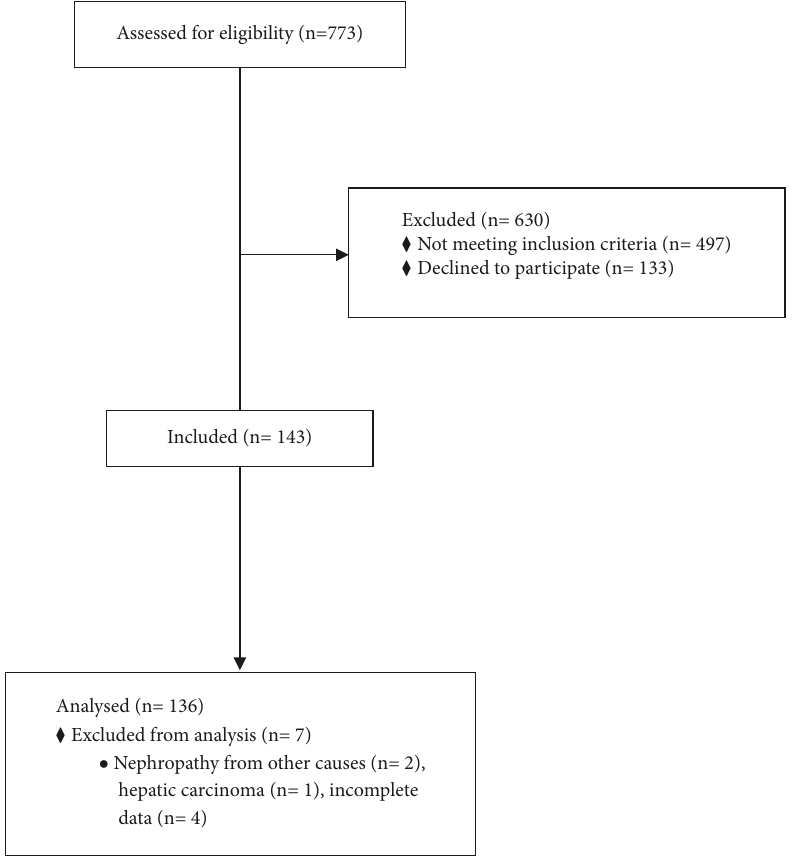
Figure 1: Flow chart of participants of the